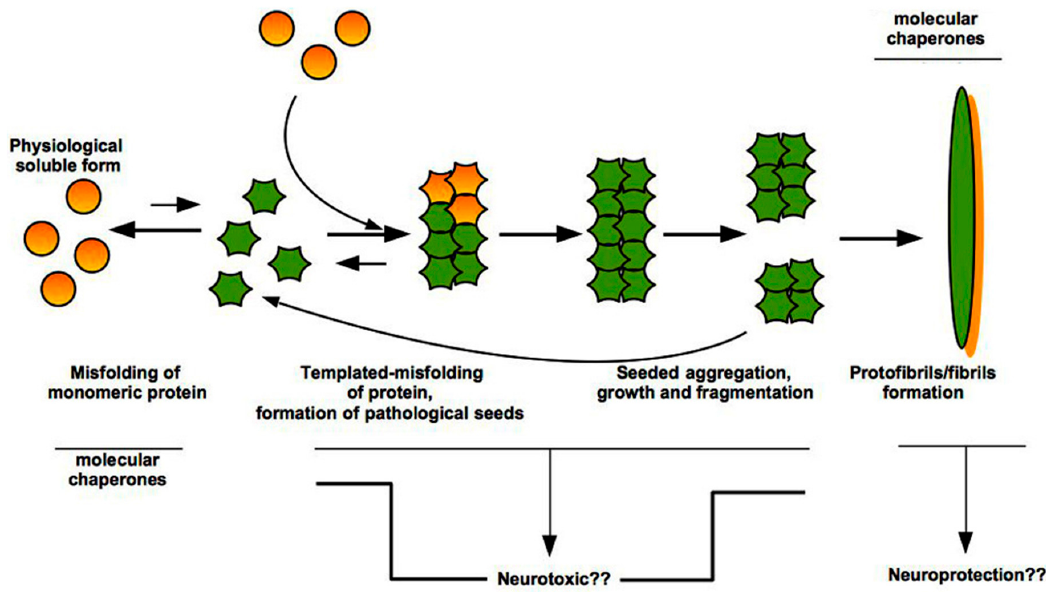
Figure 2. Prion-like mechanism of misfolded protein aggregation. Misfolding of normal physiological form of a protein and formation of pathological seeds is a rare and energetically unfavourable event, based upon exposition of amide groups and high concentration of a given protein. Genetic mutations or environmental factors (e.g., exposure to infective PrPSc, pesticides) can induce the conversion from soluble normal form to insoluble pathological oligomers and larger species that aggregate and fibrillize. Once a seed has formed, thanks to a template-assisted misfolding, each single molecule can acquire a different shape and add to growing aggregates. These latter can be fragmented generating new seeds that are able to accelerate the aggregation, giving life to fibrils formation. Question marks (??) indicate open issues.